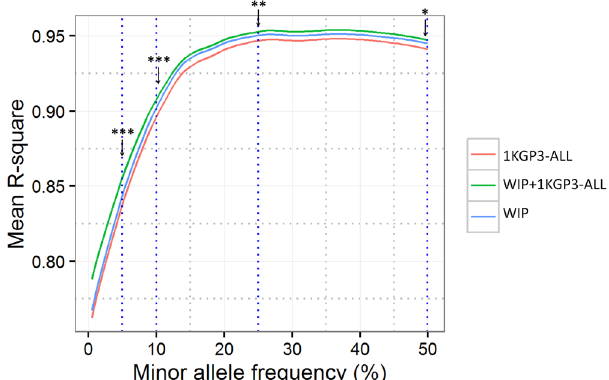
Figure 2. Evaluation of population-specific reference panel for imputation accuracy. Affy6.0 SNPs from 1880 individuals from Western India were imputed at khap 3000 using 3 different reference panels: The 1000 Genomes Phase 3 (1KGP3-ALL), Western-Indian reference panel (WIP) and mergedWestern-Indian-1KGP3- ALL (WIP + 1KGP3-ALL). Average r-square values were plotted against each minor allele frequency (MAF) bin. Two-tailed paired-end TTEST was performed for the mean r-square values at given MAF-bins between 1KGP3- ALL and WIP + 1KGP3-ALL panel imputed SNPs. ‘p’ values of < 0.001, < 0.01 and < 0.05 are indicated by *** , ** and * respectively. Results are restricted to SNPs on chromosome 20